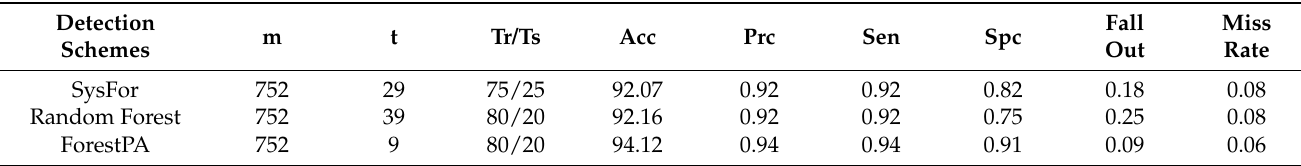
Table 10. Maximum performance received for decision forests with minimum number of decision trees on all feature segments of Istanbul acoustic